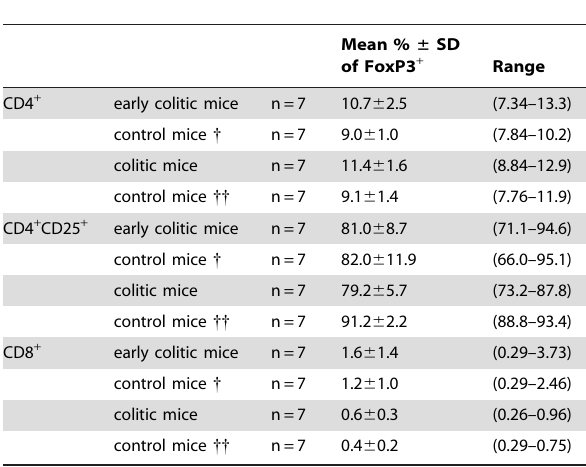
Table 1. Frequency of FoxP3 + T cells in CD4 + , CD4 + CD25 + and CD8 + subpopulations from mesenteric lymph nodes (MLN), as determined by flow cytometry.